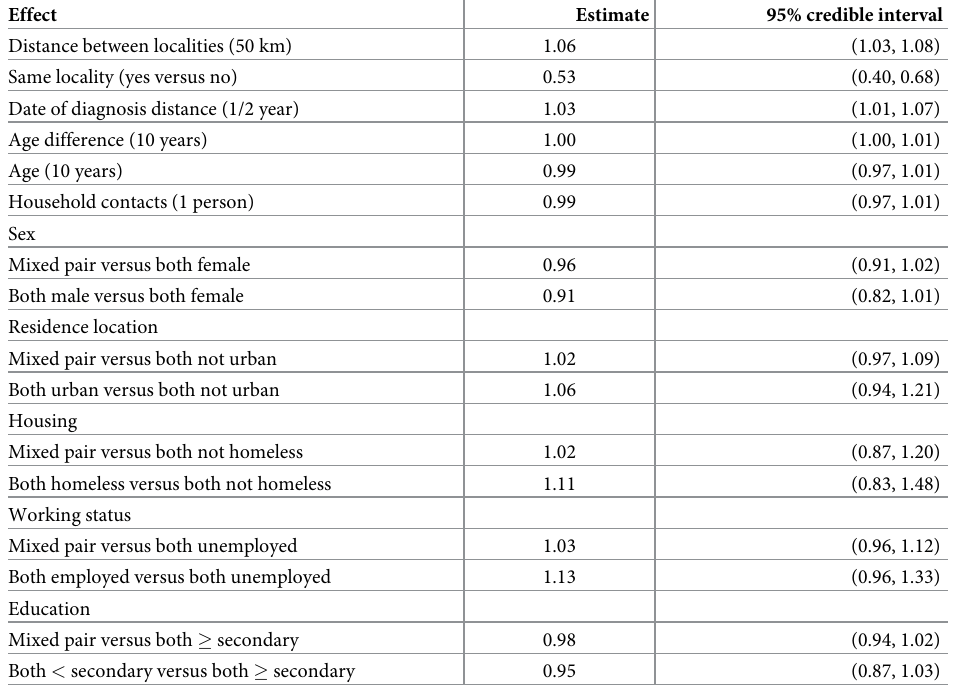
Table 2. Pooled Bayesian meta-analysis inference for each exponentiated effect (i.e., RR interpretation).